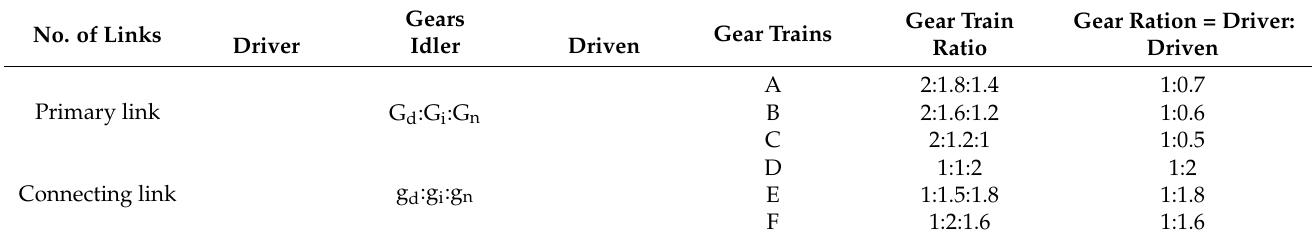
Table 2. Gear train ratio combinations of primary and connecting